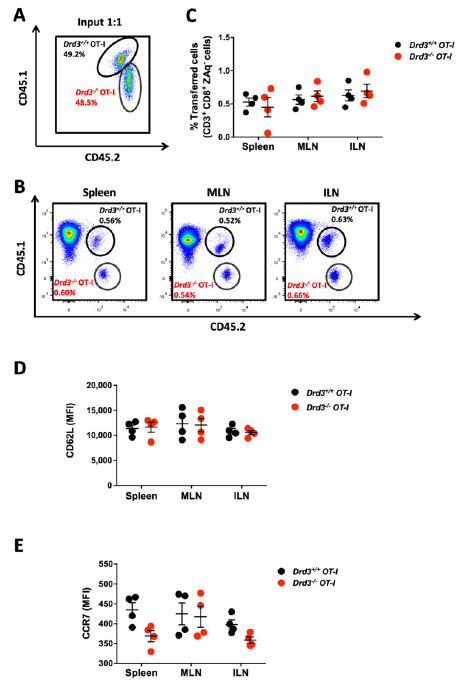
Figure 2. Drd3 -deficiency does not affect CD8 + T-cell migration through secondary lymphoid organs. Splenic CD8 + T-cells were isolated from Drd3 +/+ Cd45.1 +/- CD45.2 +/- or Drd3 -/- Cd45.1 -/- CD45.2 +/+ OT-I mice and then mixed in a 1:1 ratio and i.v. transferred into Cd45.1 +/+ CD45.2 -/- male C57BL/6 mice (2 × 10 6 total cells/mouse). Twenty-four hours later, inguinal lymph nodes (ILN), mesenteric lymph nodes (MLN), and the spleen were collected, and CD8 + T-cells were analysed by flow cytom- etry. ( A ) A representative dot-plot of the input of 1:1 mixed donors’ cells is shown. ( B ) Representa- tive dot-plots analysing the proportion of Drd3 +/+ (CD45.1 + CD45.2 + ) and Drd3 -/- (CD45.1 - CD45.2 + ) donor’s OT-I cells in the CD8 + ZAq - gate from different secondary lymphoid organs are shown. (A and B) Numbers indicate the percentage of cells in the indicated region. ( C ) Quantification of the percentage of Drd3 +/+ and Drd3 -/- donors’ OT-I cells in the CD8 + ZAq - gate. ( D , E ) Quantification of the MFI associated with CD62L ( D ) and CCR7 ( E ) expression on Drd3 +/+ and Drd3 -/- donors’ OT-I cells infiltrating different secondary lymphoid organs are shown. ( C – E ) Each symbol represents